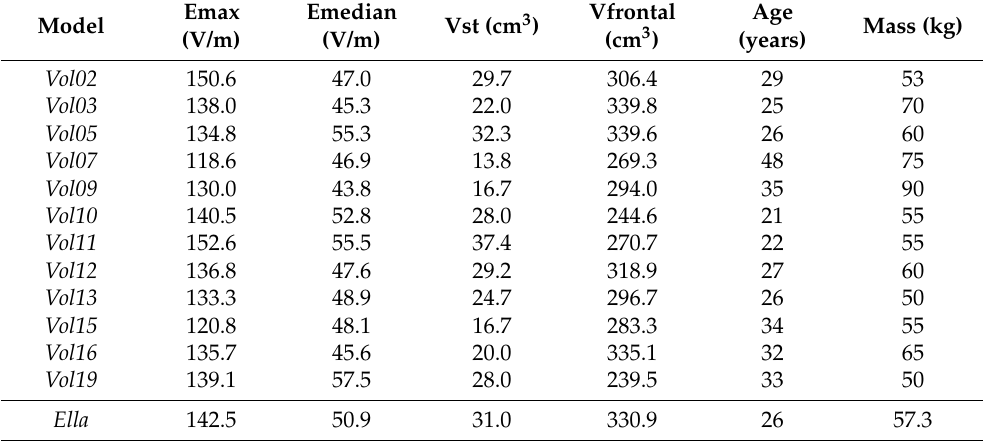
Table A4. Stimulation metrics (Emax, Emedian, and Vst) on the frontal lobe and model parameters (frontal lobe volume, age, mass) of the homogeneous female models and the homogeneous version of the Ella ViP